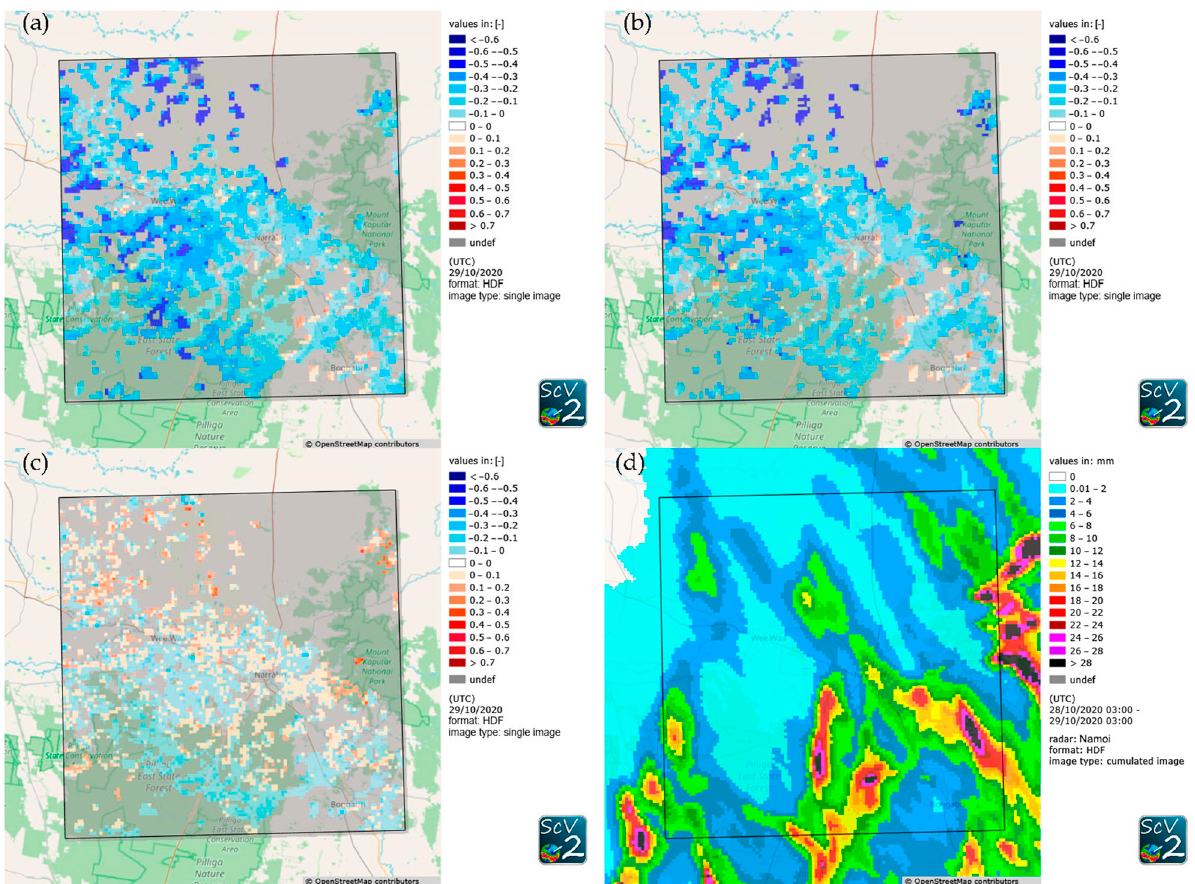
Figure 8. Relative soil moisture change (dimensionless) calculated as the difference between consecutive days of relative soil moisture for scenario 1 ( a ), for scenario 2 ( b ), and from the difference between scenario 1 and 2 ( c ) for 29/10/2020. Positive values mean an increase in soil moisture, while negative values mean a decrease in soil moisture. Additionally, the respective cumulated radar precipitation is shown ( d